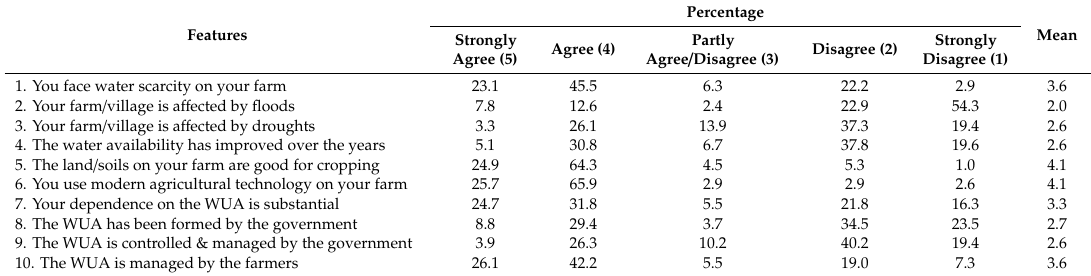
Table 5. Features of the water situation, water-user association (WUA) and institutional environment. Percentage Features MeanStrongly Agree (5)